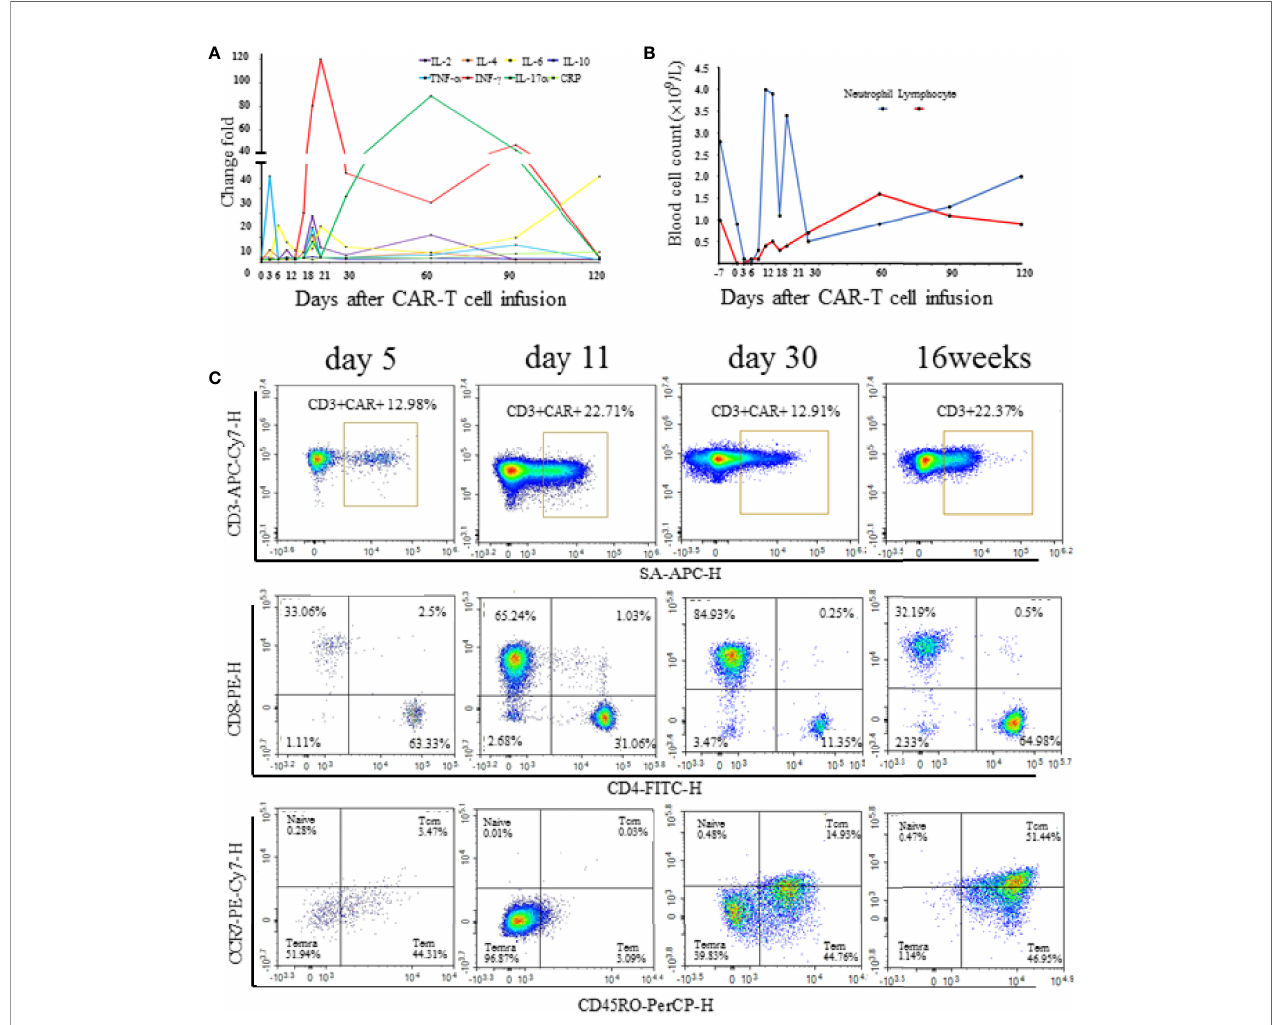
FIGURE 3 | (A) The serum cytokine and C-reactive protein levels at different time points after CAR-T cell infusion. Change folds are relative to the values of day -7 before chemotherapy. (B) Neutrophil and lymphocyte count at different time points after CAR-T cell infusion. (C) Proportion and subtype of CAR-T cell at different time points after CAR-T cell